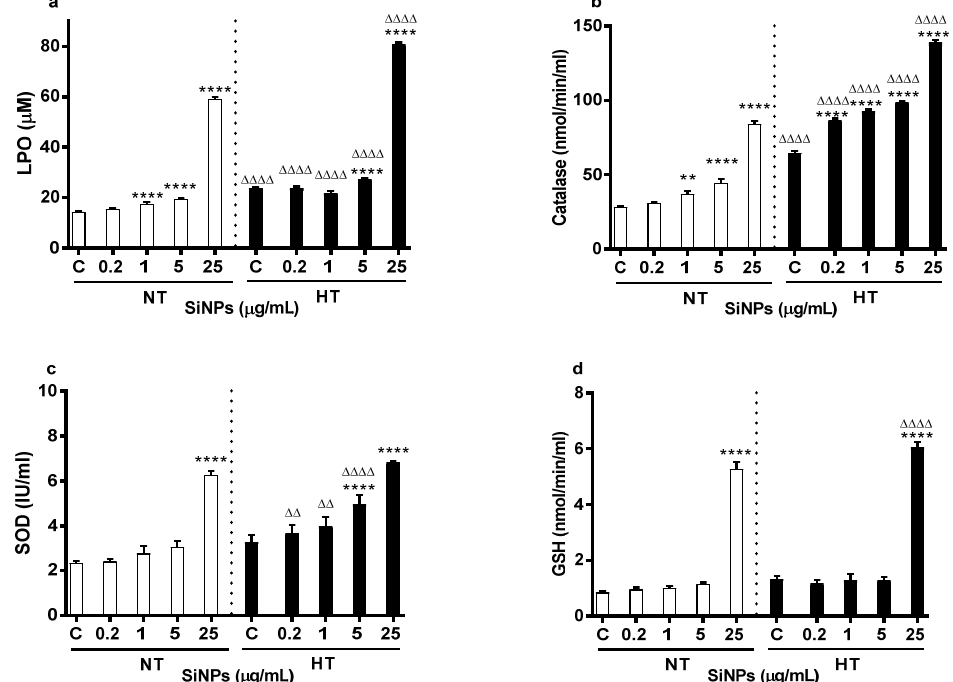
Figure 5. Effect of various concentrations ( µ g/mL) of silica nanoparticles (SiNPs) on lipid peroxidation concentration (LPO, ( a )), catalase activity ( b ), superoxide dismutase activity (SOD, ( c )) and reduced glutathione concentration (GSH, ( d )) measured in the incubation medium of erythrocytes obtained from normotensive (NT) and hypertensive (HT) rats. Data are mean ± SEM ( n = 8 in each group). Statistical analysis by one-way analysis of variance (ANOVA) followed by the Holm-Sidak multiple comparisons test. ** p < 0.01, **** p < 0.0001 vs. respective control and ∆∆ p < 0.01, ∆∆∆∆ p < 0.0001 vs. respective concentration in NT group.